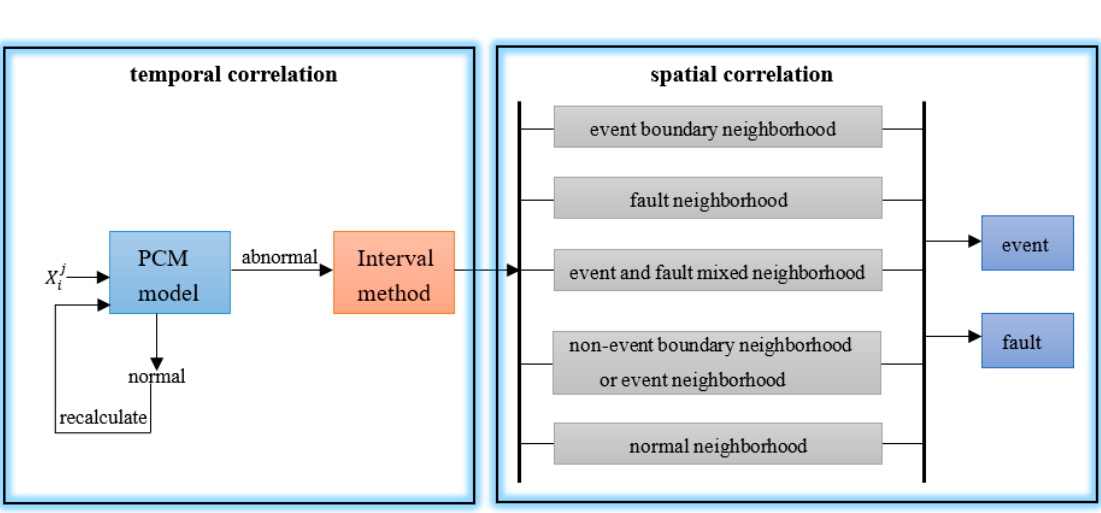
Figure 2. Architecture of our model for anomaly detection in the WSN.